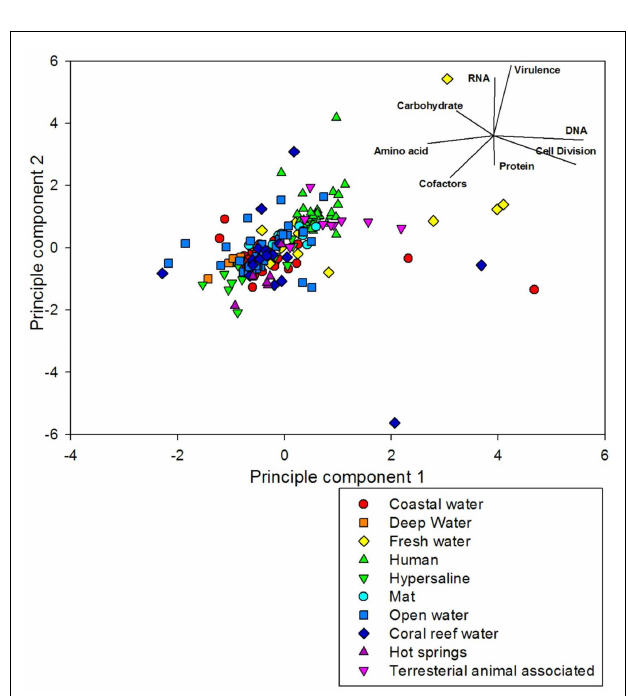
FIGURE 8 | Principal component analysis of the 212 metagenomes using the top eight variables identified from the random forest analysis. The samples are colored and shaped by the environment where they came from.The samples are largely aligned on a 45˚ plane from virulence-DNA metabolism to amino